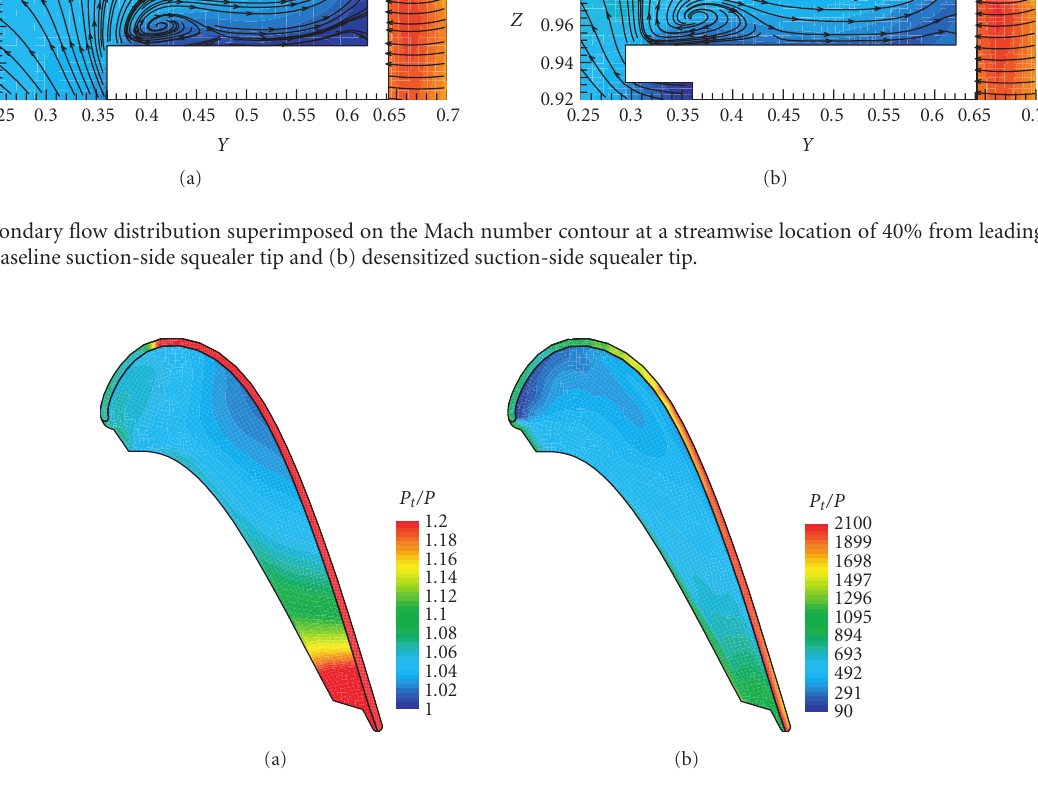
Figure 18: (a) Pressure ratio and (b) heat transfer contours on the desensitized suction-side squealer tip having a constant